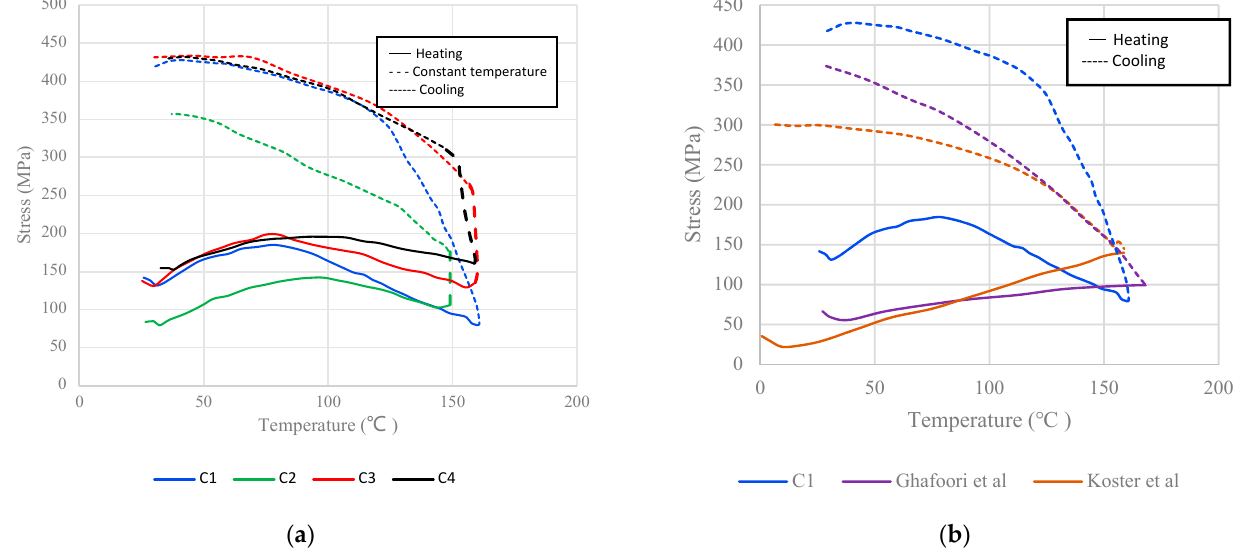
Figure 10. ( a ) Stress vs. temperature graph for all specimens, C1–C4; and ( b ) comparison with the literature [40,44].